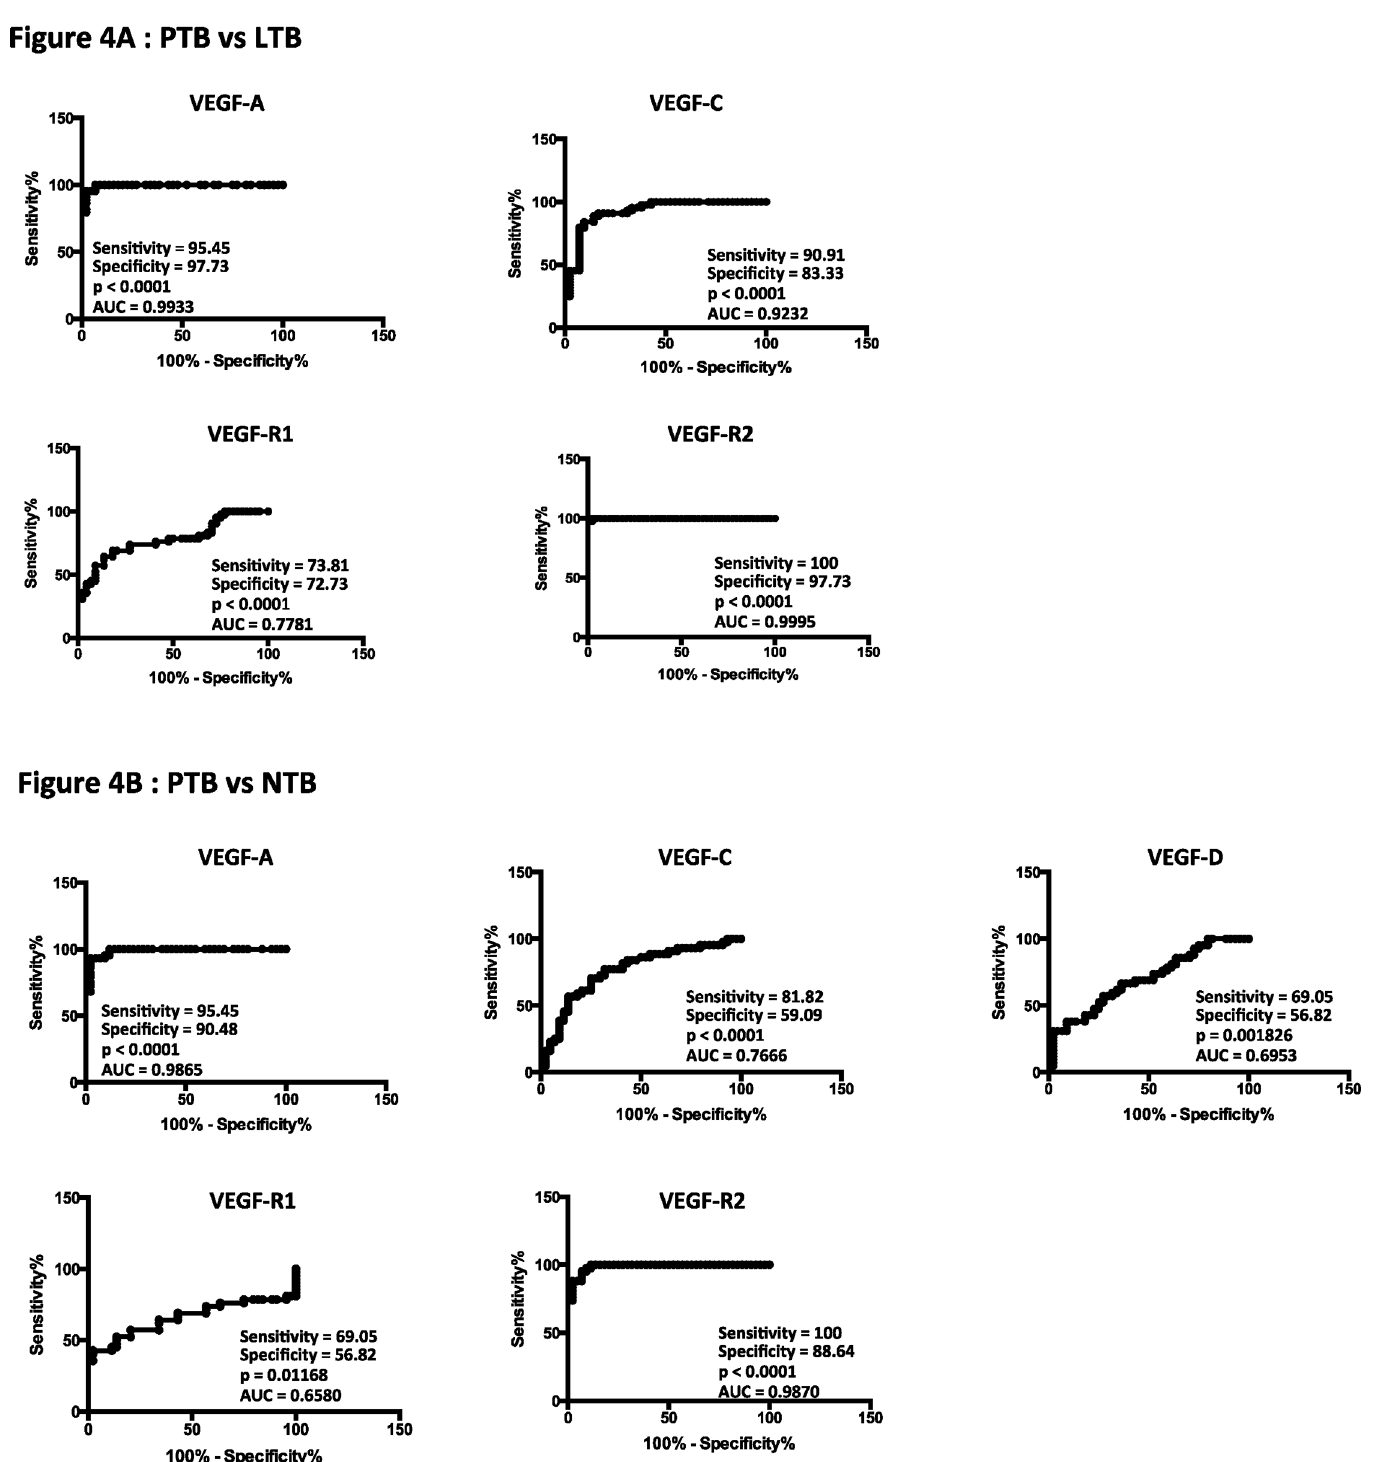
Fig 4. ROC analysis to estimate the discriminatory power of systemic angiogenic factors in PTB individuals. (A) ROC analysis to estimate the sensitivity, specificity and area under the curve was performed using all the systemic angiogenic factors (VEGF-A, C, VEGF-R1, R2 and R3) to estimate the capacity of these factors to distinguish PTB versus LTB individuals. (B) ROC analysis to estimate the sensitivity, specificity and area under the curve was performed using all the systemic angiogenic factors (VEGF-A, C and D, VEGF-R1, R2 and R3) to estimate the capacity of these factors to distinguish PTB versus NTB